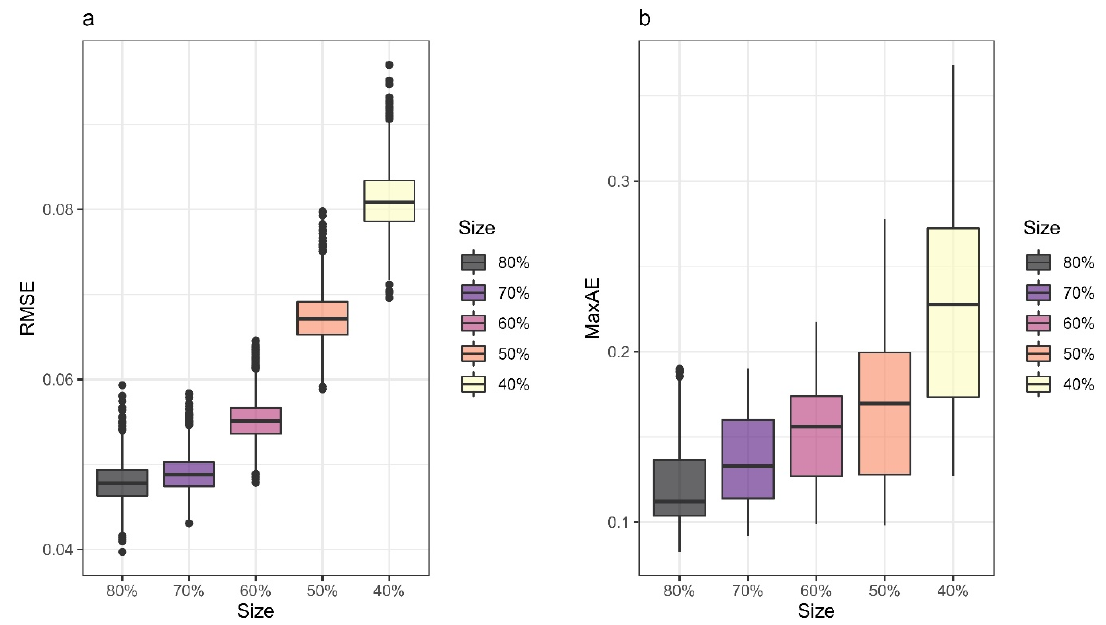
Figure 10. The calculated ( a ) RMSE and ( b ) MaxAE box plots for test sets resulting from the models trained by different sample sizes for 5000 times.